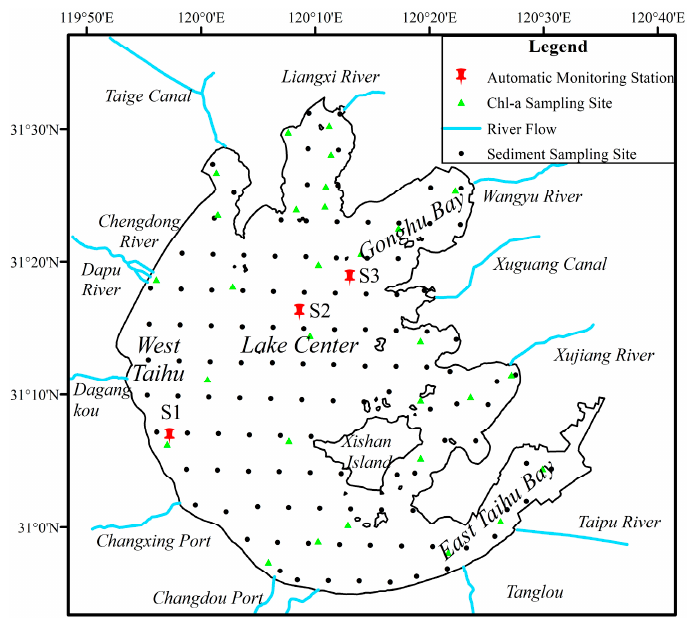
Figure 1. Lake Taihu and locations of monitoring stations, Taihu Laboratory for Lake Ecosystem Research chlorophyll- a sampling sites, inflows, outflows, and sediment sampling sites.